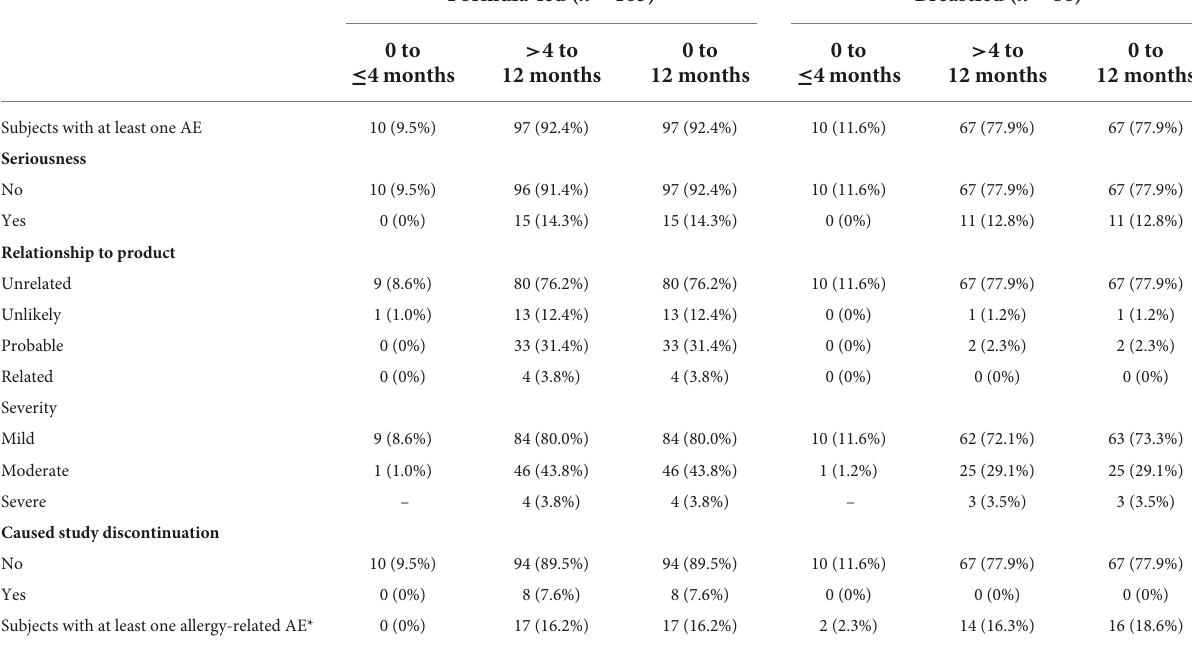
TABLE 4 Adverse events (AE) by feeding group and time period (SAF